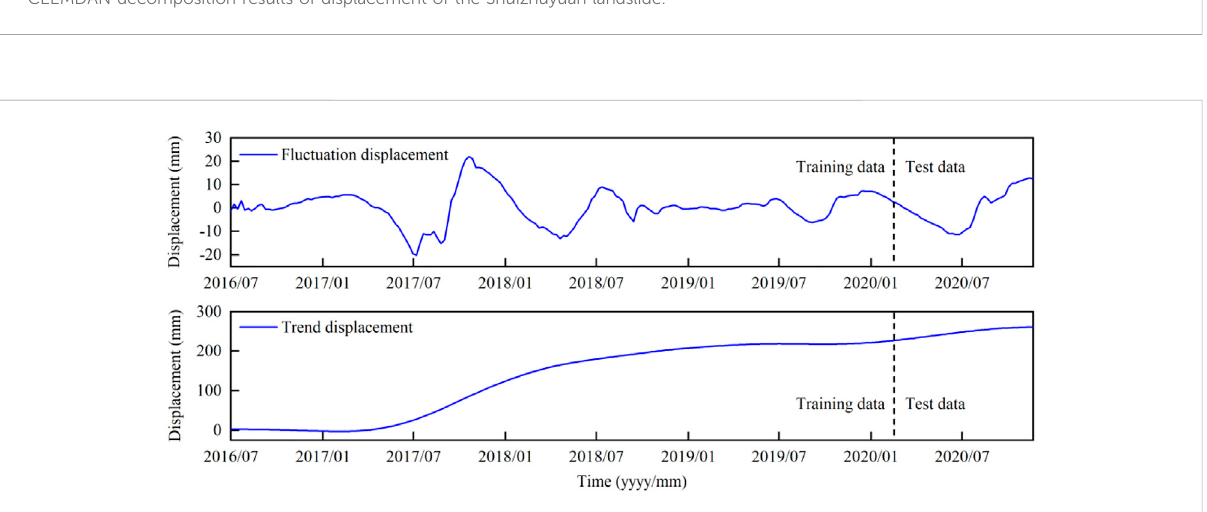
FIGURE 6 The fl uctuant and trend displacement of the Shuizhuyuan